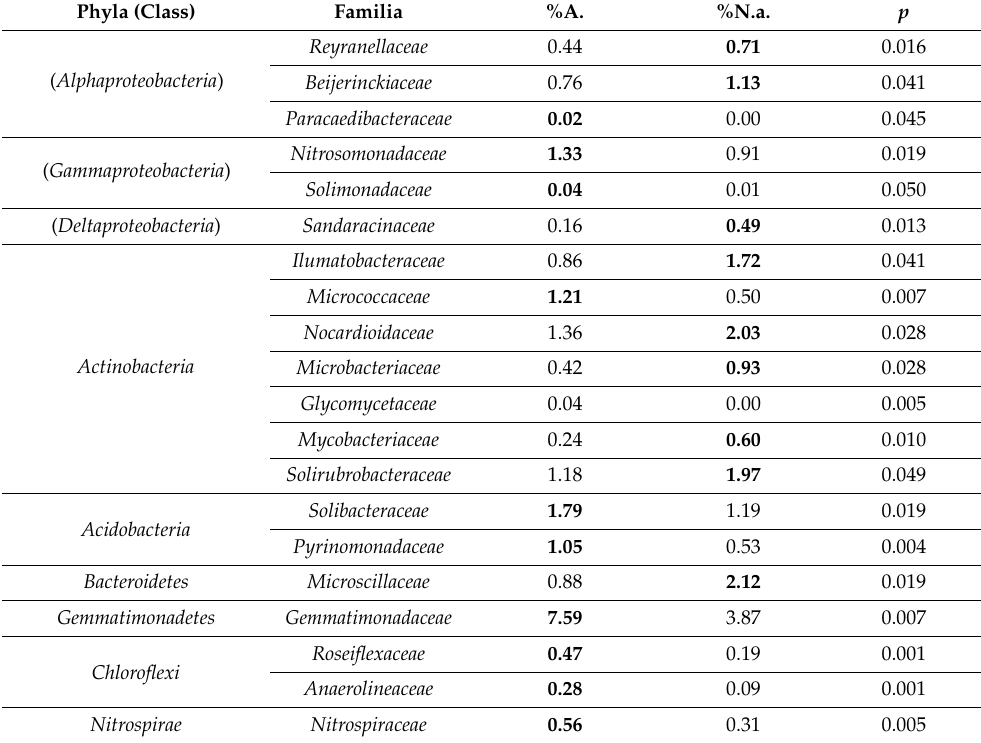
Table 4. Average percentage of families that differs in their share in arable (A.) and nonarable (N.a.) grounds. Bigger values given in